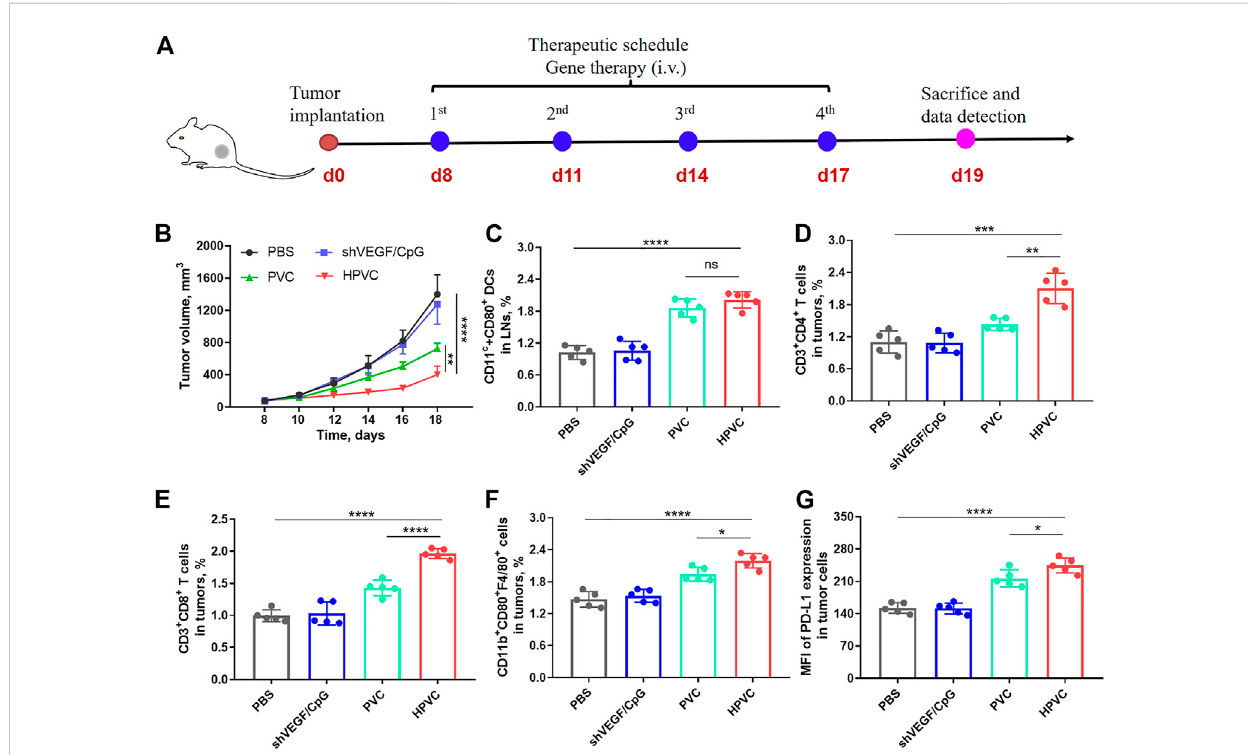
FIGURE 4 AntitumortherapybyHPVC. (A) SchematicillustrationofantitumortherapyofCT26tumor-bearingmicebyHPVC. (B) Averagetumorgrowthcurves of mice in different treatment groups ( n = 5). (C) Flow cytometry analysis of DC maturation in LNs. Flow cytometry analysis of (D) CD3 + CD4 + T cells, (E) CD3 + CD8 + T cells and (F) CD11b + CD80 + F4/80 + macrophages. (G) Mean fl uorescence intensity (MFI) of PD-L1 expression in tumor cells. ns =